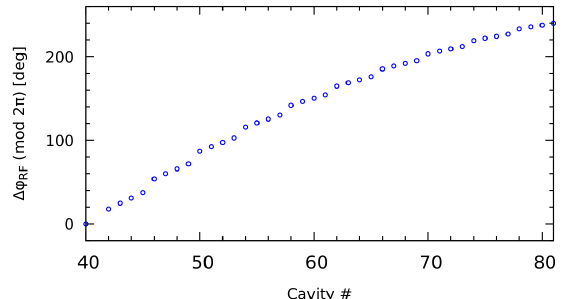
FIG. 13. Change in the control system input rf phase settings relative to those in regular operation for the SRF cavities downstream of the disabled cavity.